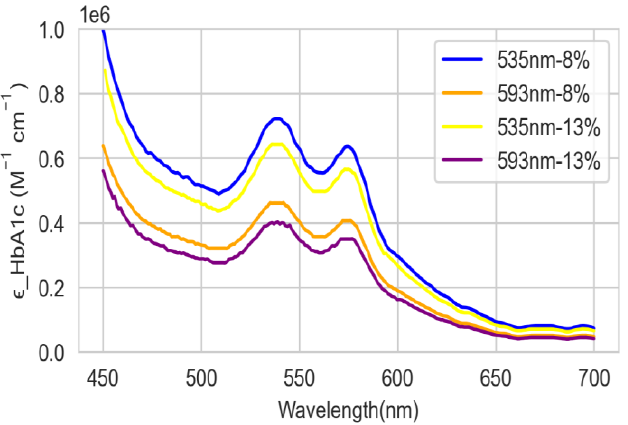
Figure 2. Theoretically calculated molar absorption coefficients of HbA1c [21].